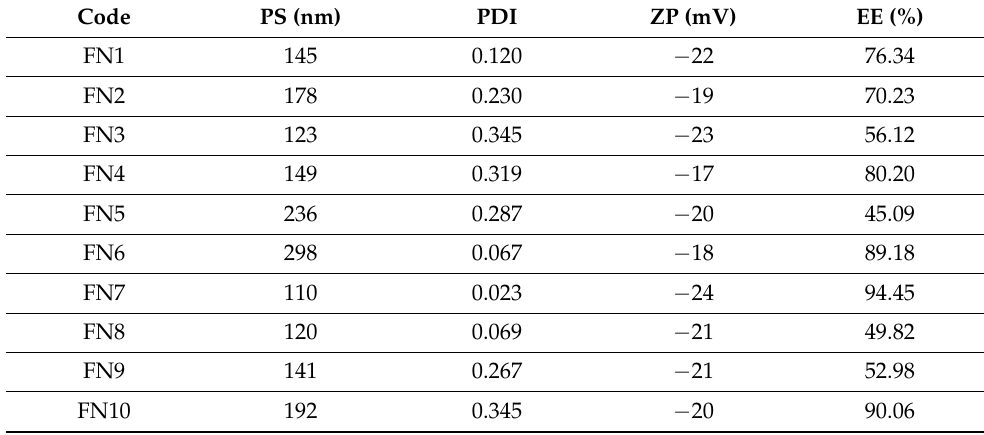
Table 1. PS, PDI, ZP and EE of all novasome